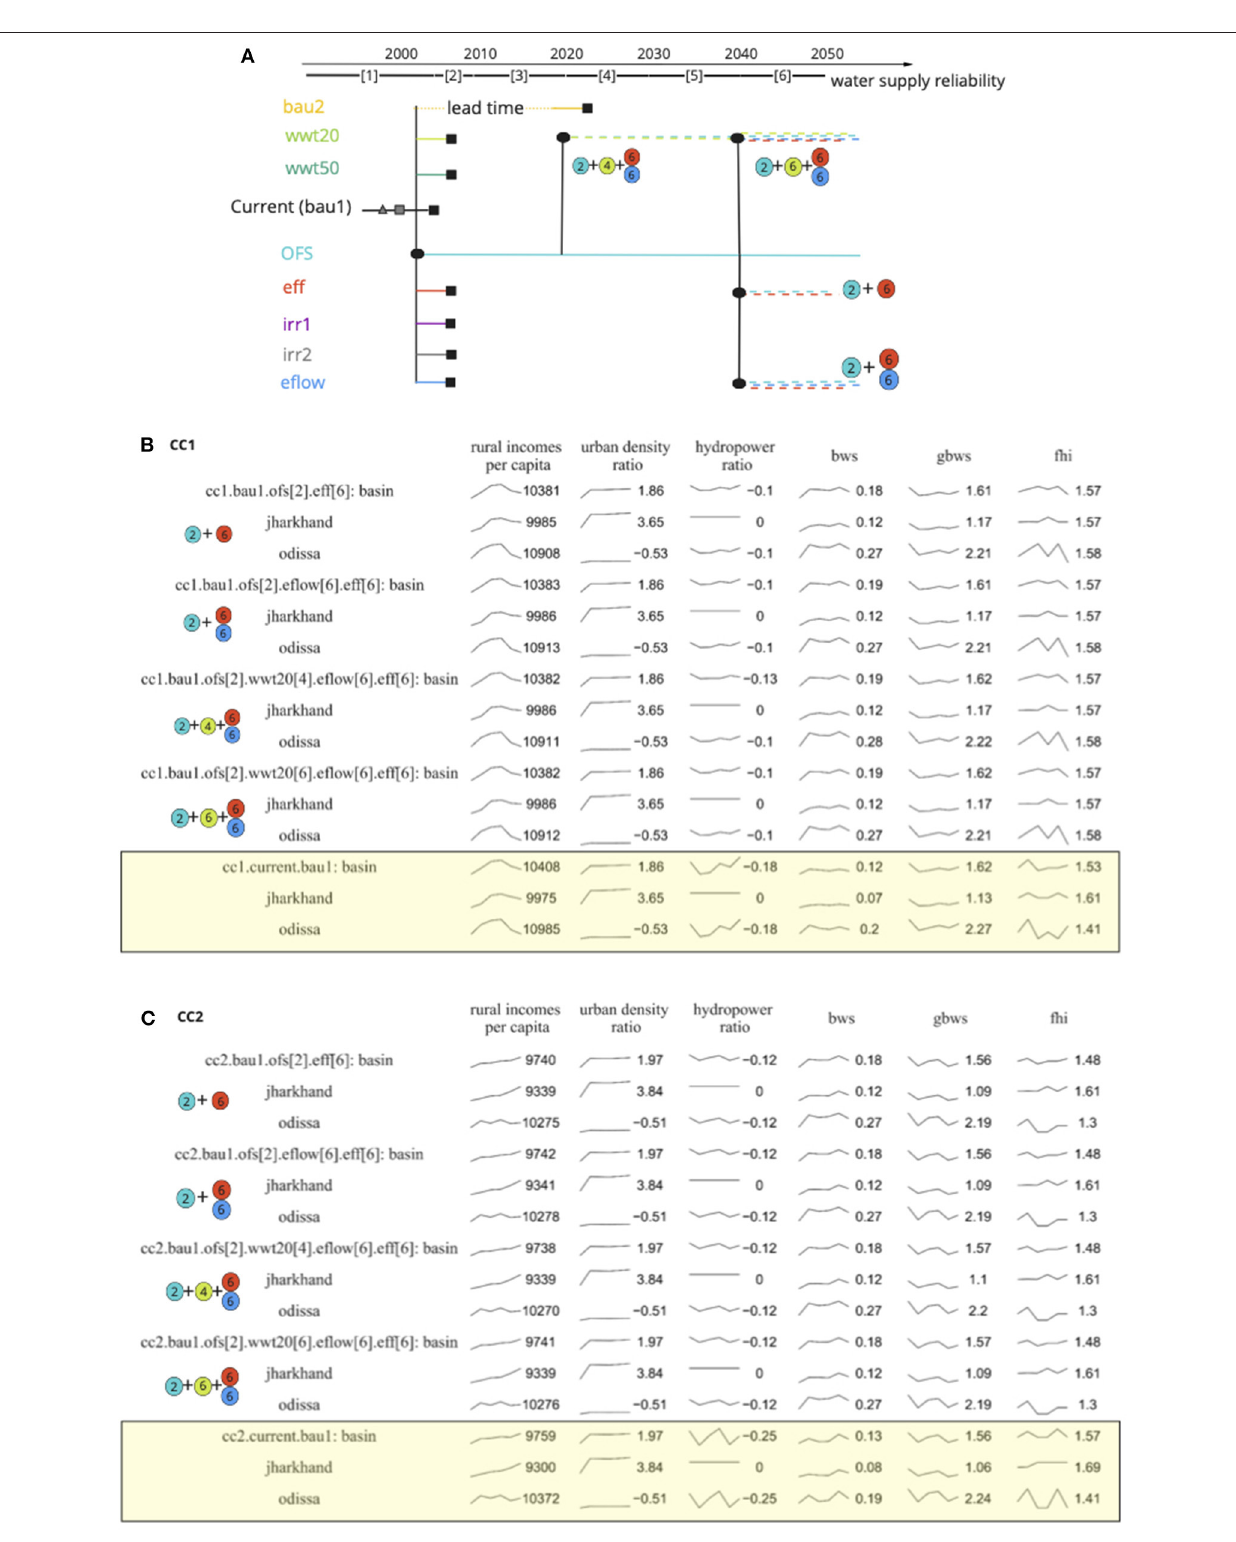
FIGURE 6 | Example of plausible adaptation pathways for the BRB system. (A) Metro map for selected adaptative pathways and their associated scorecards under the two future scenarios: global socioeconomic increase of inequalities under (B) drier climate ( cc1 ) and (C) wetter climate ( cc2 ). Adaptation pathways in